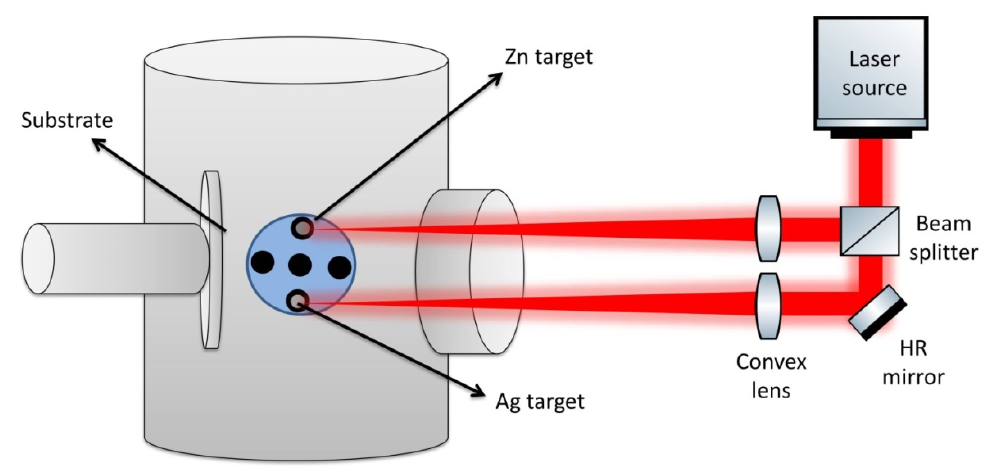
Figure 1. Representative graph of the preparation thin film of Ag/ZnO by PLD .